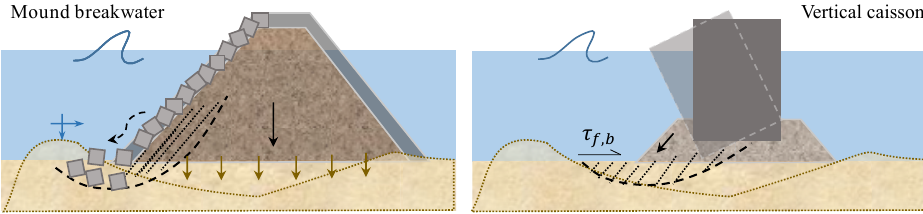
Figure 2. Failures of maritime structures due to the seabed failure: ( left panel ) instability of the armour layer; ( right panel ) settle and collapse of the